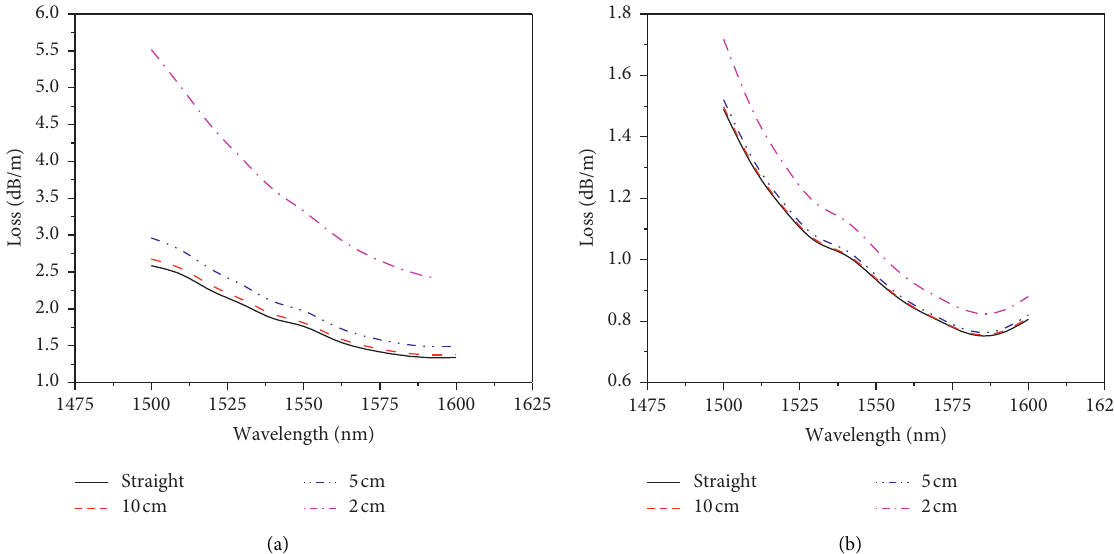
Figure 10: Fiber bends in x direction, the bending loss of (a) x polarization mode and (b) y polarization mode curve at different bending